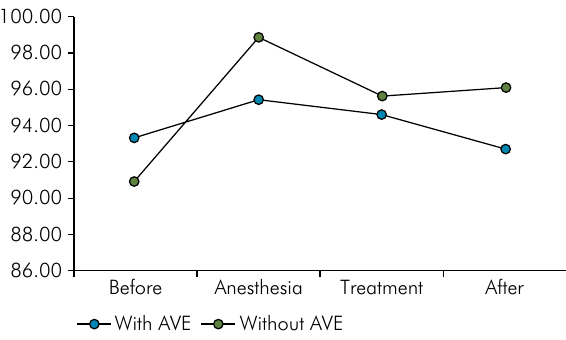
Figure 2. Mean hearth rate during the different moments of the dental visit according to the group.